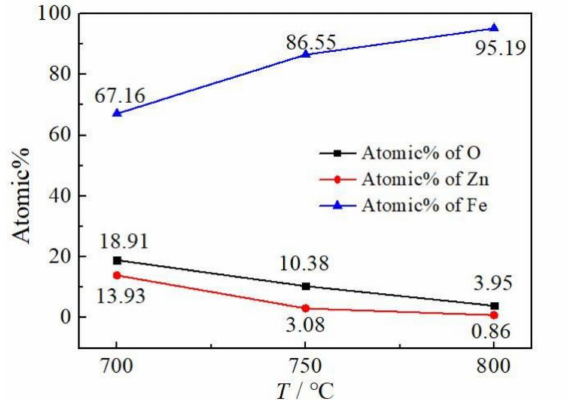
Figure 14. The relationship between the content of each element as the temperature increases ( E = 1.8 V, t = 8